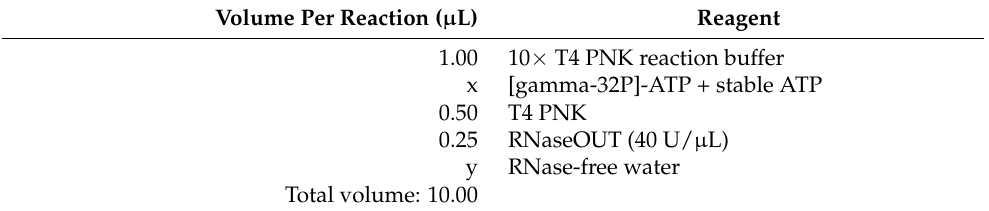
Table 7. RNA-Primer Mix for Reverse